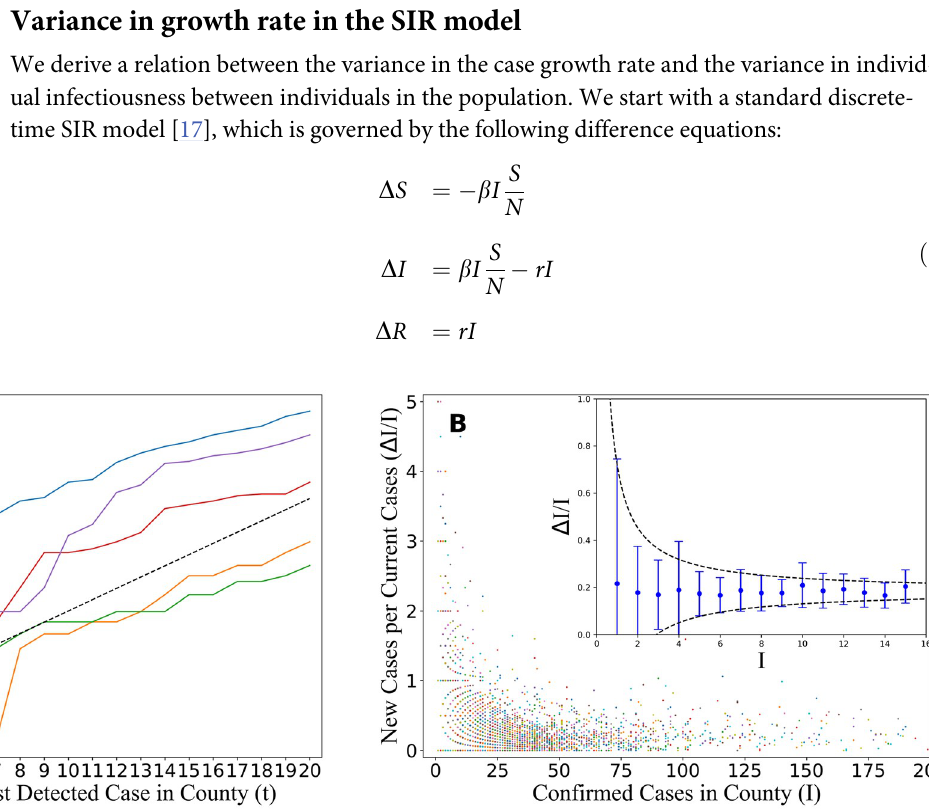
Fig 1. (a) Illustration of the variance in early-time growth rate of new cases. At early times, there is noticeable variance in the growth rate between counties. As the number of cases grows, all counties stabilize towards the average growth rate I � (1+ μ β ) t , (dashed black line) where t is the number of days since the first case in a county. The counties shown are Boulder, CO (blue), St. Mary, LA (purple), Vanderburgh, IN (red), Mesa, CO (orange), and Jones, GA (green). (b) The number of daily infections per infected individual as a function of total infections. In the main figure, each point corresponds to a given county (across all US counties that never report Δ I < 0) at a given time point (within the first 14 days after the first infection reported in that county). As the number of cases increase, all counties converge to the mean infection rate. The mean (points) and variance (bars) of Δ I / Þ = I (black I at a given I are shown in the inset. The variance decreases like ð m b þ s 2 b